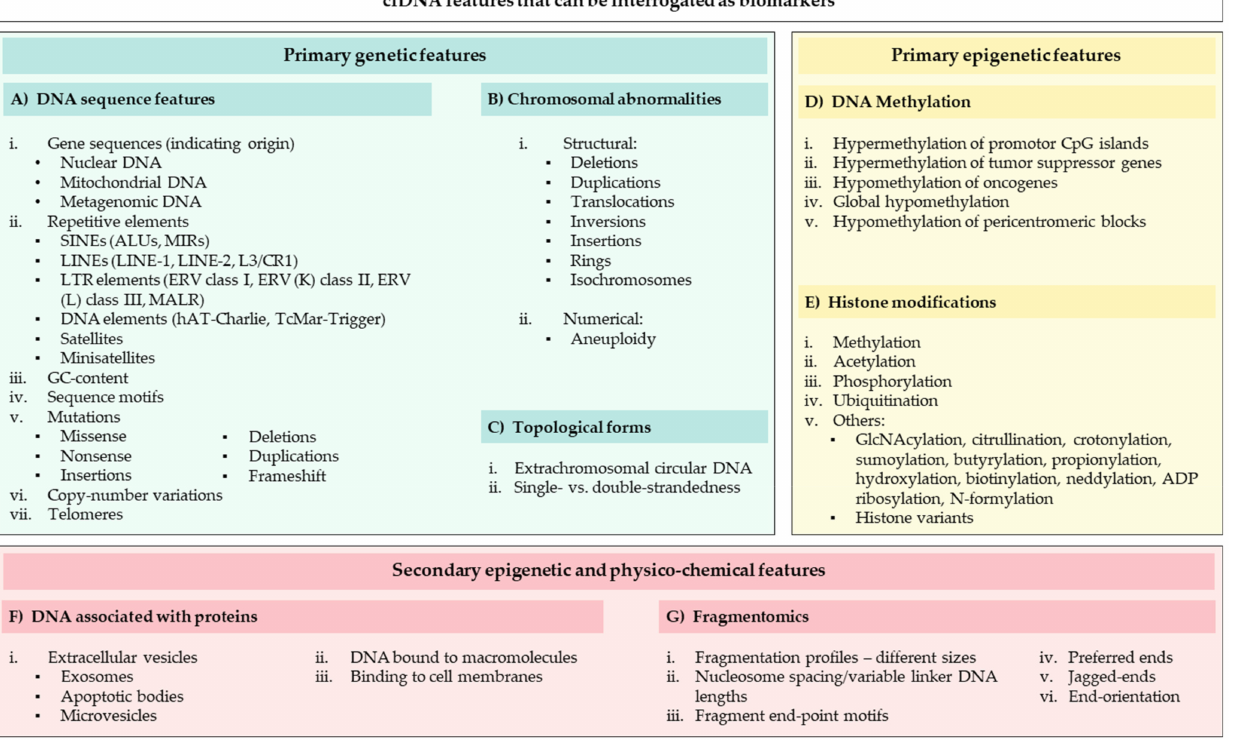
Figure 4. Features of cfDNA that could serve as clinical biomarkers. In addition to DNA hotspot mutations, various disease- and tissue-specific genetic, epigenetic, and structural features are encoded into cfDNA. Much of this information can be leveraged for the detection and monitoring of a wide range of diseases, physiological states, and other clinical